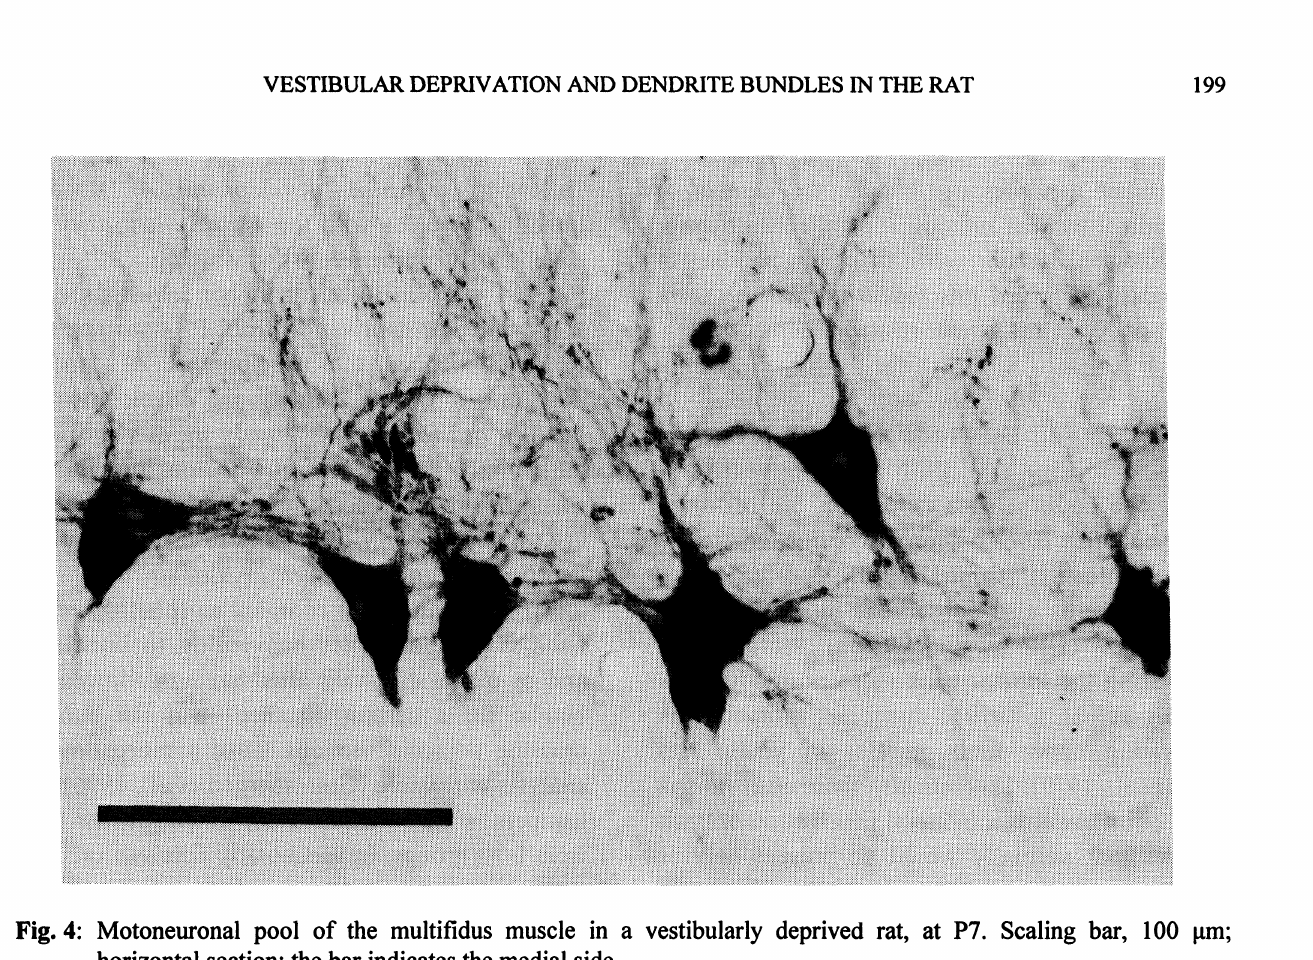
Fig. 4: Motoneuronal pool of the multifidus muscle in a vestibularly deprived rat, at P7. Scaling bar, 100 ttm; horizontal section; the bar indicates the medial